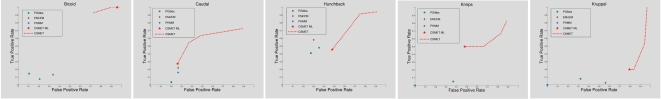
ROC of CSMET with different values of functional evolutionary (i.e., TFBS turnover) rates on Drosophila CRMs.